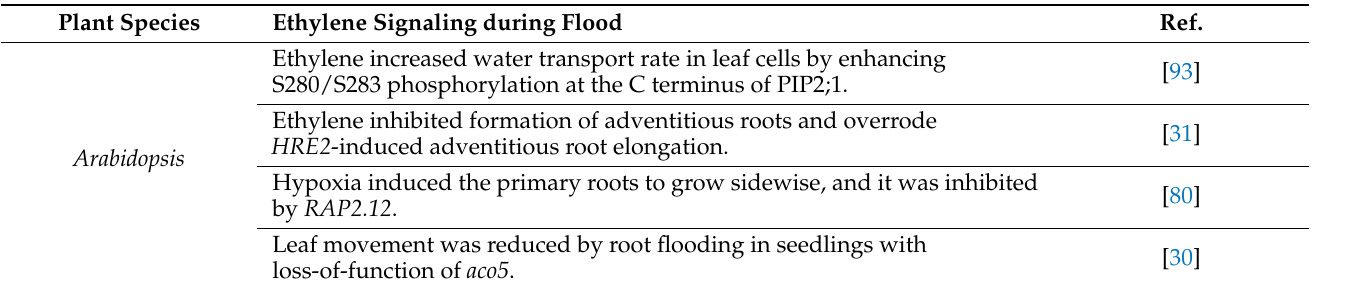
Table 2. Ethylene signaling in plants during flooding stress. Plant Species